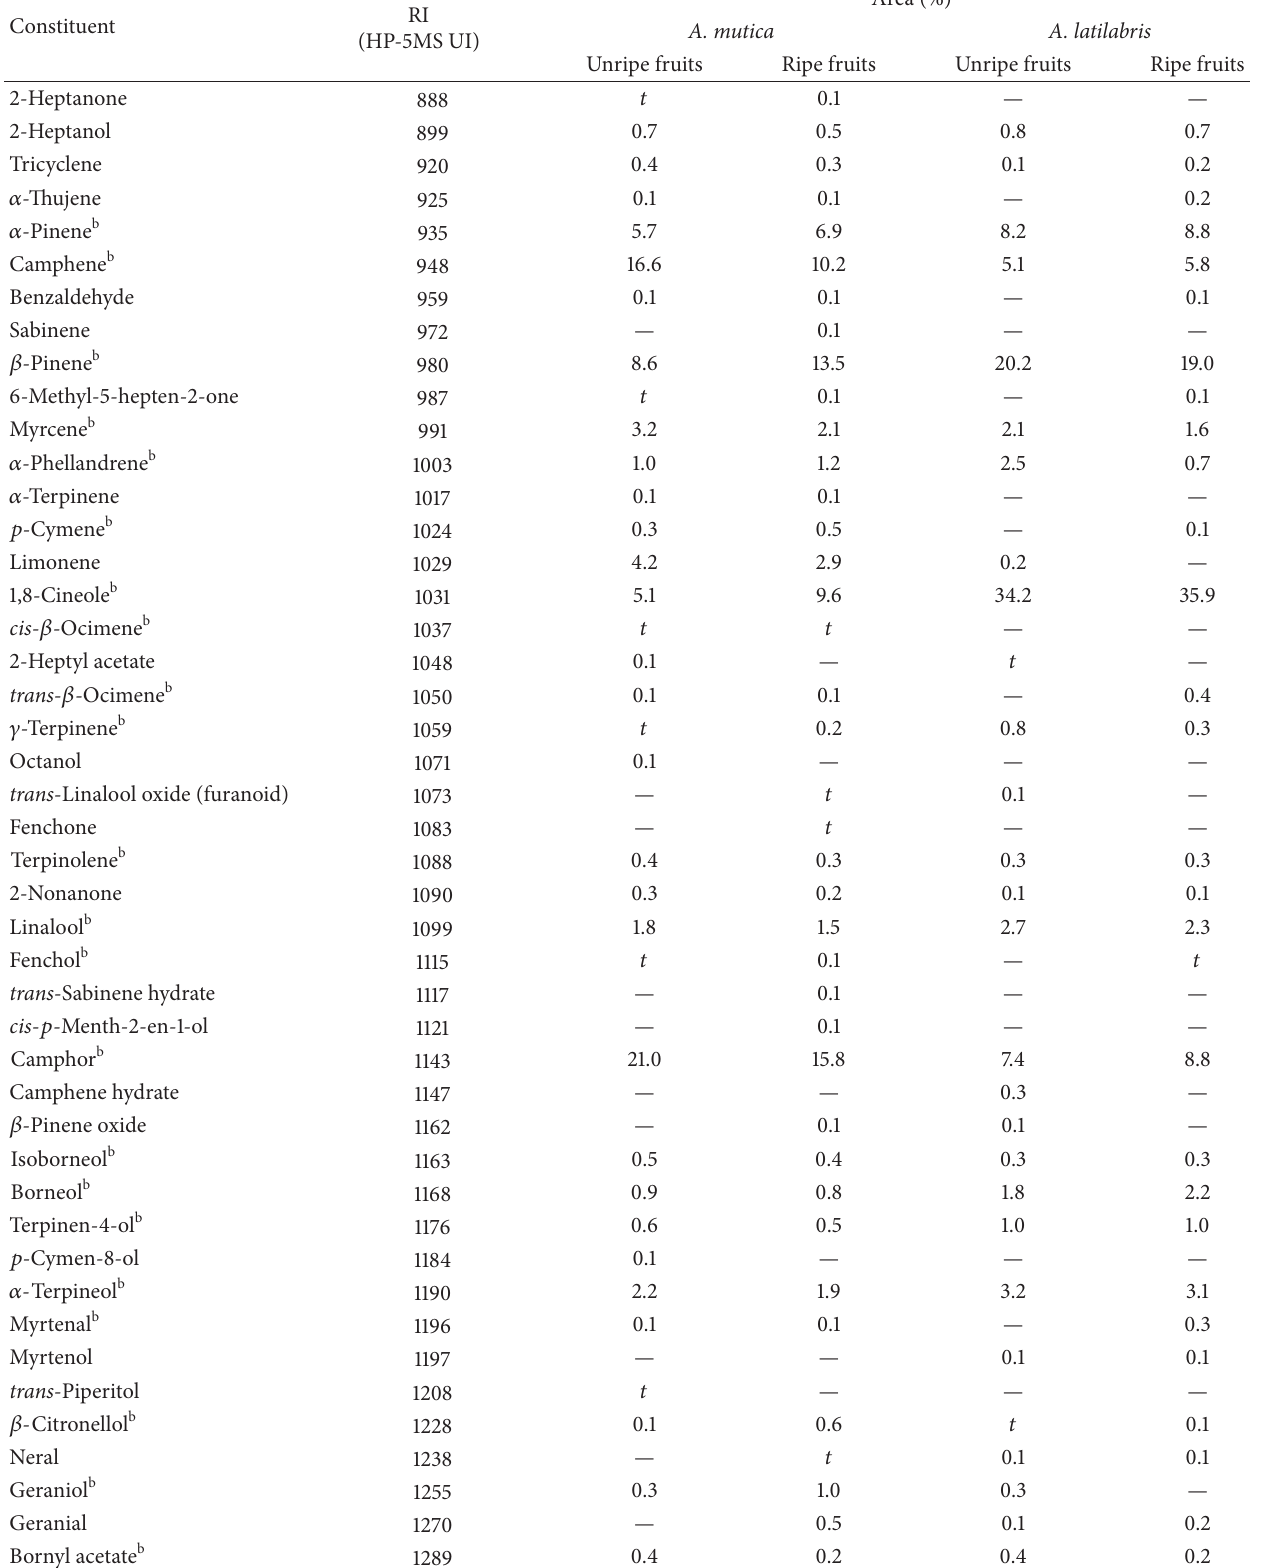
Table 1: Essential oil constituents of the flowers, unripe and ripe fruits of A. mutica Roxb. and A. latilabris